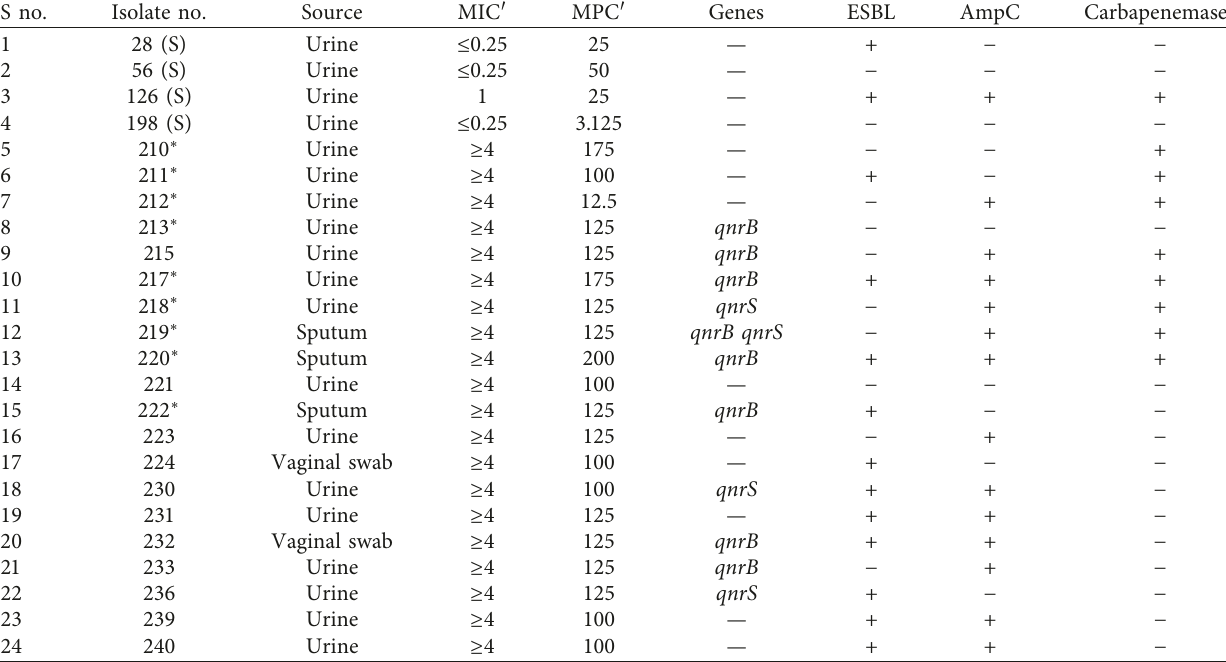
Table 2: MPC, MIC, ESBL, AmpC, and carbapenemase detection in clinical isolates of K. pneumoniae . S no. Isolate no.